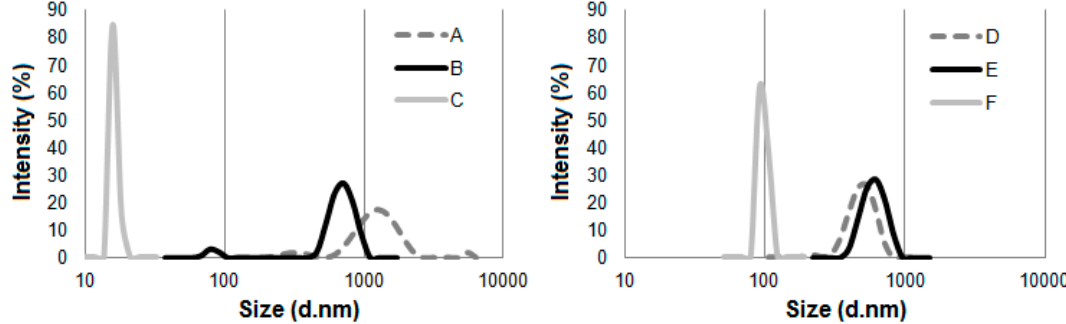
Figure 4. The average particle size of the cellulose before and after treatment with ionic liquids: ( A ) Avicel, ( B ) Avicel treated with [EMIM][Cl], ( C ) Avicel treated with [PMIM][Cl], ( D ) Sigmacell, ( E )